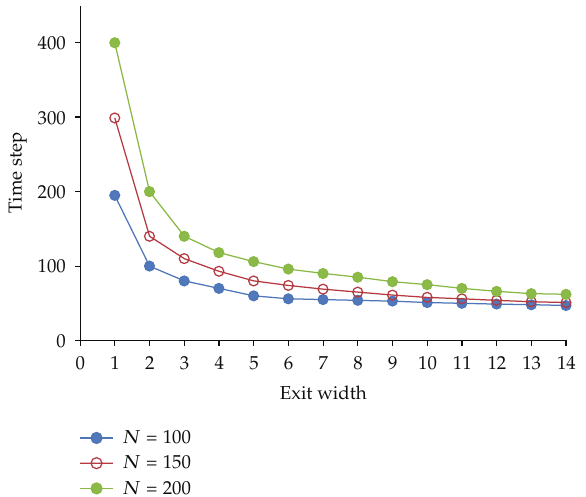
Figure 7: Relationship between exit width and evacuation time (cid:2) in time steps (cid:3) for the room in Figure 5, with 100, 150, and 200 occupants initially distributed